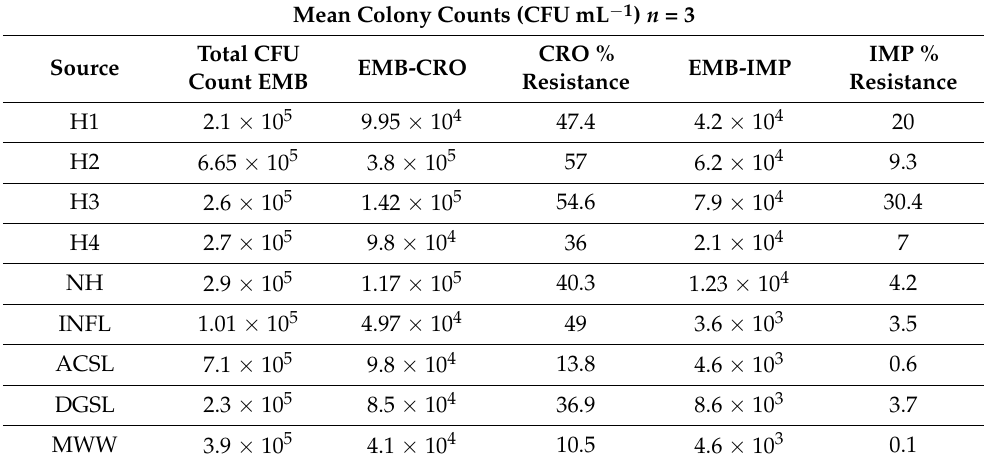
Table 1. The average concentration of bacteria growing on EMB, EMB-CRO, and EMB-IMP samples from hospitals, nursing home, wastewater treatment stages, and municipal wastewater